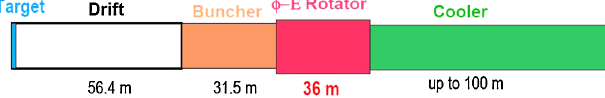
FIG. 2. (Color) Schematic of the neutrino factory [9] front-end transport system, showing an initial drift (56.4 m), the varying frequency buncher (31.5 m), and the phase-energy ( (cid:4) - (cid:5)E ) rotator (36 m) leading into a cooling section of up to 100 m. (A 75 m cooling length may be optimal.)